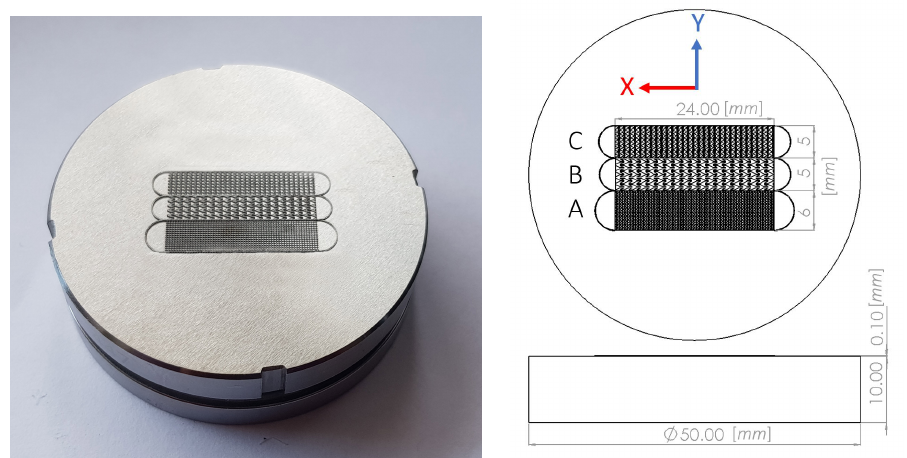
Figure 2. Three adjacent structures exhibiting fin shaped channels added to the steel base by SLM. ( left ) Actual A, B and C structures. ( right ) CAD design documenting the total length and width of each structure, in